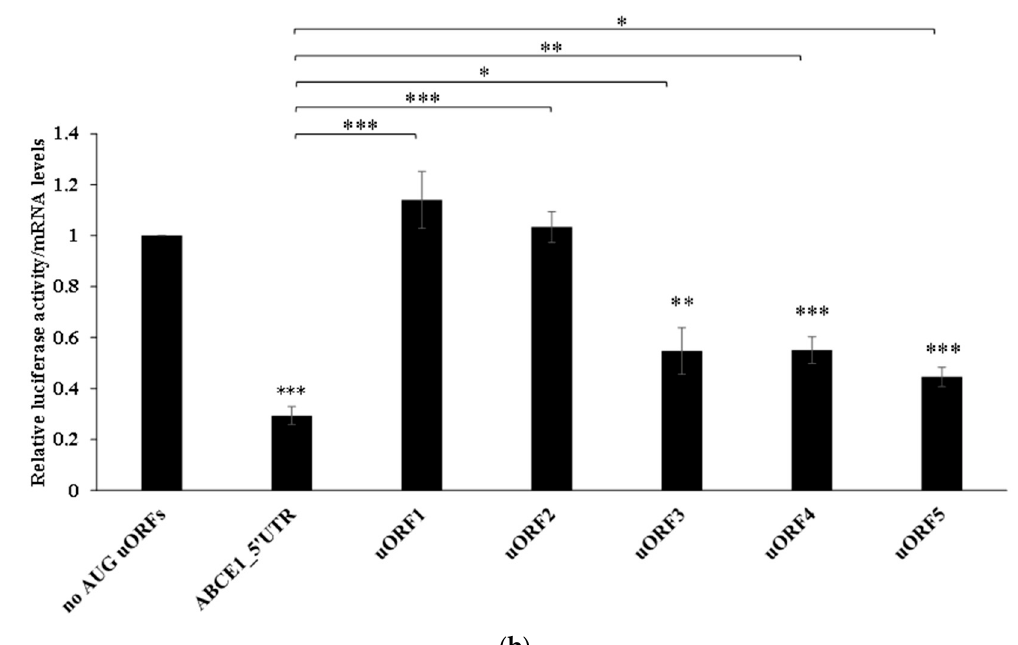
Figure 2. In the native configuration, the ABCE1 AUG uORFs significantly repress translation of the downstream main ORF, but when isolated, only uORF3, uORF4, and uORF5 function as repressors. ( a ) Schematic representation of the constructs used to study the translational regulatory function of the ABCE1 AUG uORFs. The human ABCE1 5 ′ -leader sequence was cloned into the pGL2-FLuc vector upstream of the FLuc ORF (green box), obtaining the ABCE1_5 ′ UTR construct. By site-directed mutagenesis, and using the ABCE1_5 ′ UTR vector as a template, each AUG initiation codon was mutated (ATG → TTG), creating the constructs with only one functional AUG uORF (uORF1-5, represented here by small boxes and only by its uORF number, 1 to 5, to simplify the scheme) or without functional AUG uORFs (“no AUG uORFs”). Non-AUG uORFs (represented in small boxes with the numbers 6 to 10) are maintained intact in these constructs. ( b ) HCT116 cells were transiently co-transfected with each one of the constructs described in ( a ), and the pRL-TK plasmid expressing RLuc, used as a transfection efficiency control. Twenty-four hours post-transfection, cells were harvested and lysed. Luciferase activity was measured by luminometry assays. The results are expressed as relative luciferase activity determined by normalizing FLuc activity to that of RLuc. Luciferase mRNA levels were determined by semi-quantitative RT-PCR, and relative luciferase mRNA levels were determined by normalizing FLuc mRNA levels to that of RLuc for each transfected condition. Then, relative luciferase levels were normalized to the corresponding relative mRNA levels, and these values were compared to the one of “no AUG uORFs”, arbitrarily defined as 1. The results are presented as mean ± SEM from at least three independent experiments. Student’s t-test was applied for statistical significance: p < 0.05 (*), p < 0.01 (**), and p < 0.001 (***).